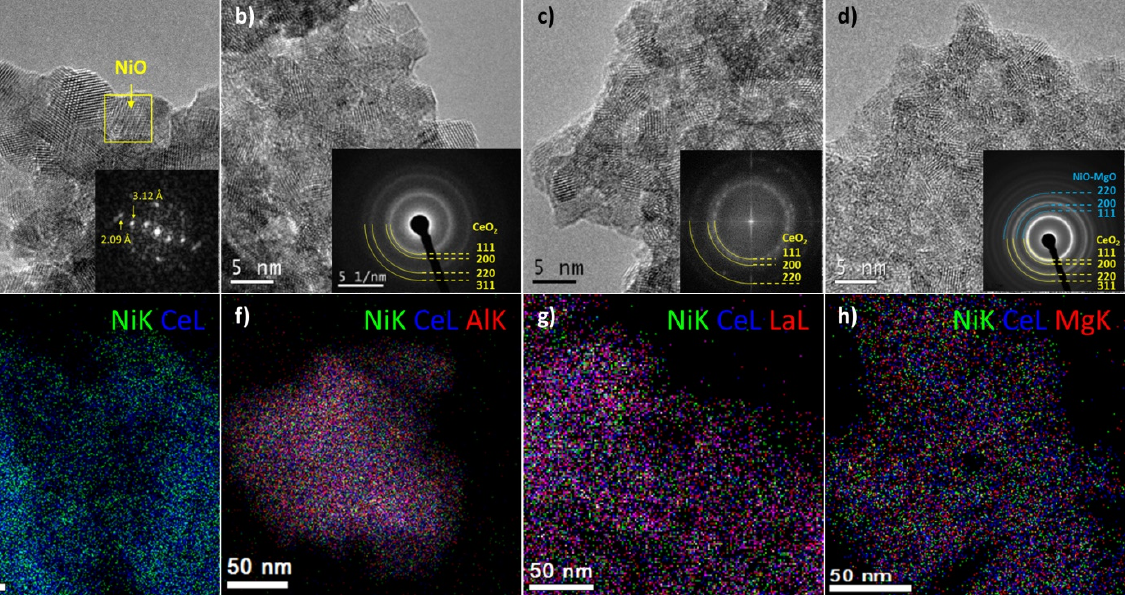
Figure 9. HRTEM pictures ( a – d ) and EDX mapping ( f – h ) of Ce 0.8 Ni 0.2 O y ( a , e ) and (CeM) 0.8 Ni 0.2 O y (M = Al ( b , f )), La ( c , g ), Mg( d , h )) samples. M/Ce = 1.